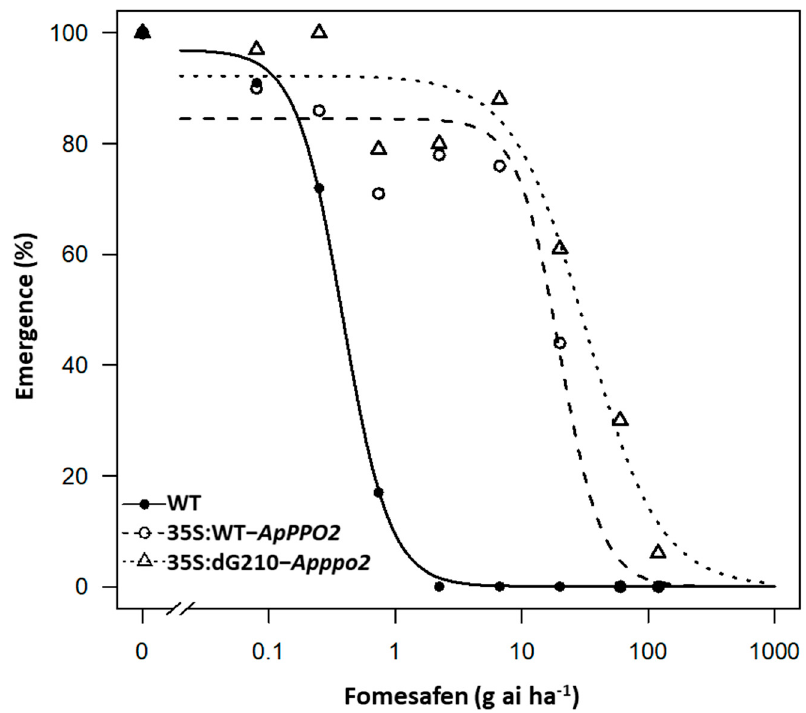
Figure 2. The dose–response curves for percentages of germinated transgenic Arabidopsis lines; WT (solid line, black circles), 35S:WT − ApPPO2 (broken line, white circles), and 35S:dG210 − Apppo2 (dotted line, white triangles) to increasing doses of soil-applied fomesafen. Table 3. Parameters estimate of the dose–response curve used to calculate the herbicide dose re- quired for decrease the 50% emergence (LD 50 ) of each Arabidopsis line evaluated three weeks after the application.